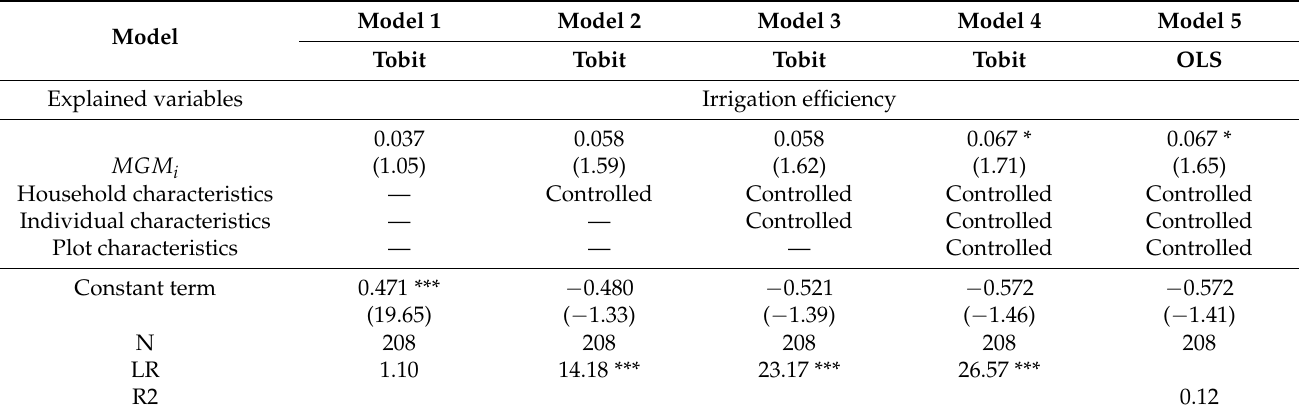
Table 7. An empirical analysis of the differences in the effects of different property rights models on the irrigation efficiency of farm households.